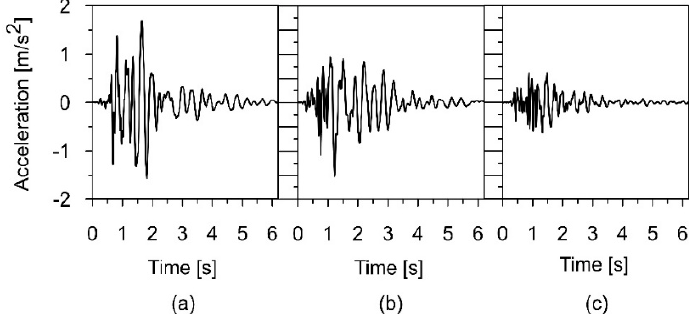
Figure 1. The time history of the ground acceleration registered in the USCB region: ( a ) horizontal direction WE; ( b ) horizontal direction NS; ( c ) vertical direction Z.